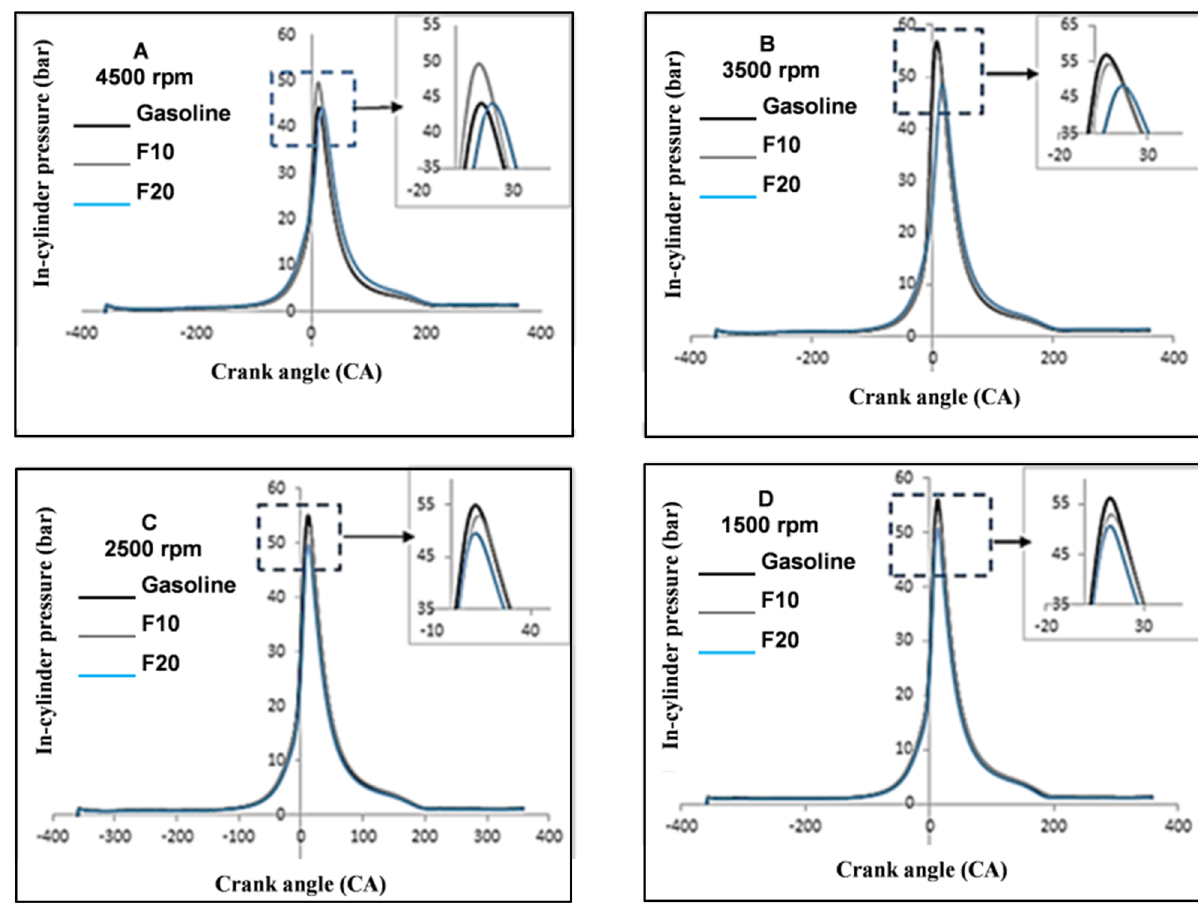
Figure 6. In-cylinder pressure variation with increasing engine